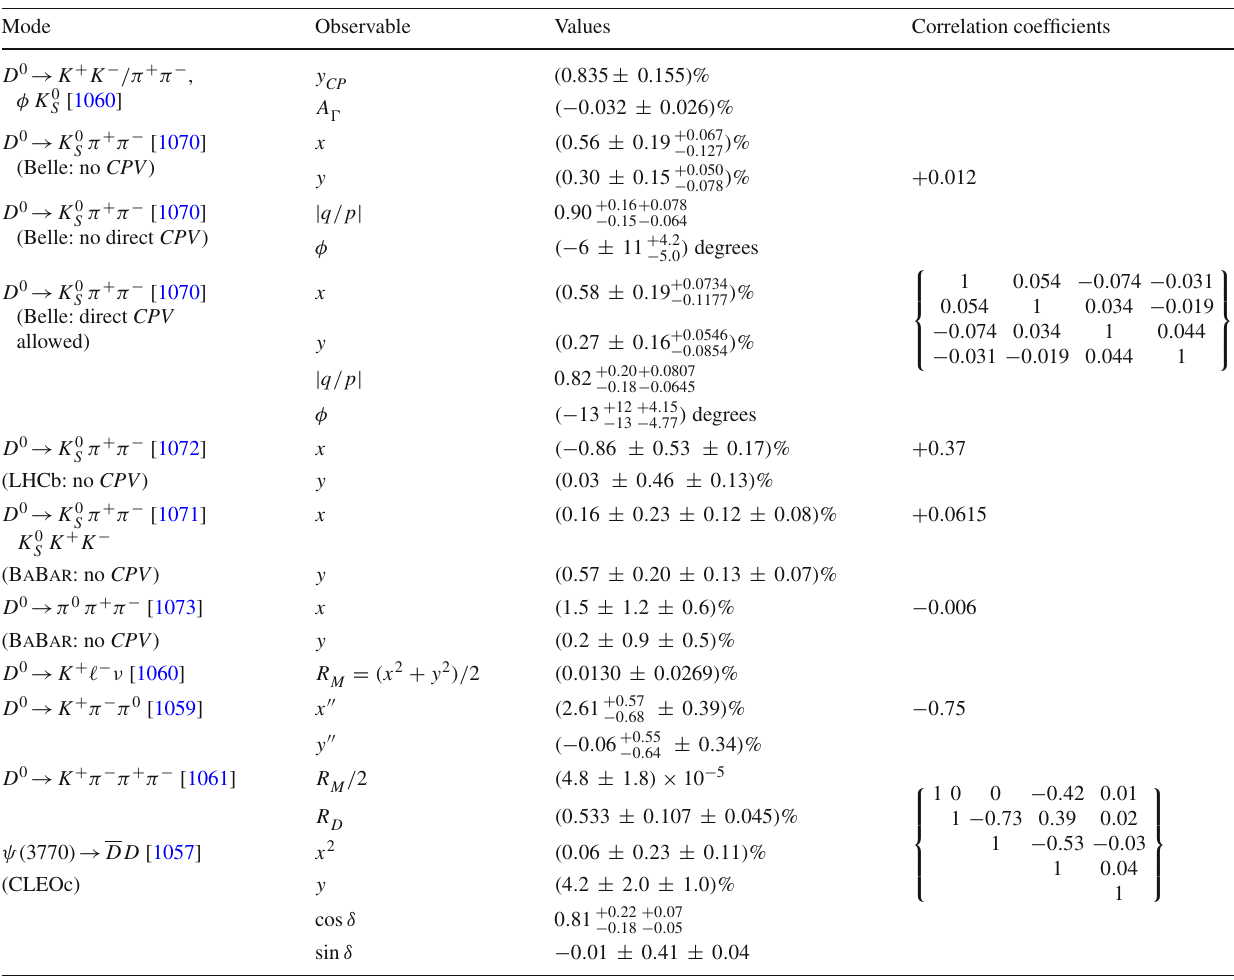
+ y sin δ + y cos δ and y (cid:7)(cid:7) ≡ − x sin δ K ππ K ππ K ππ K ππ